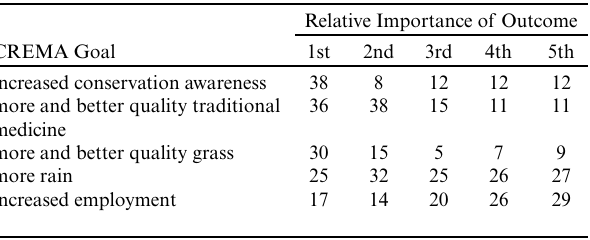
Table 2 . Results from a survey question asking respondents